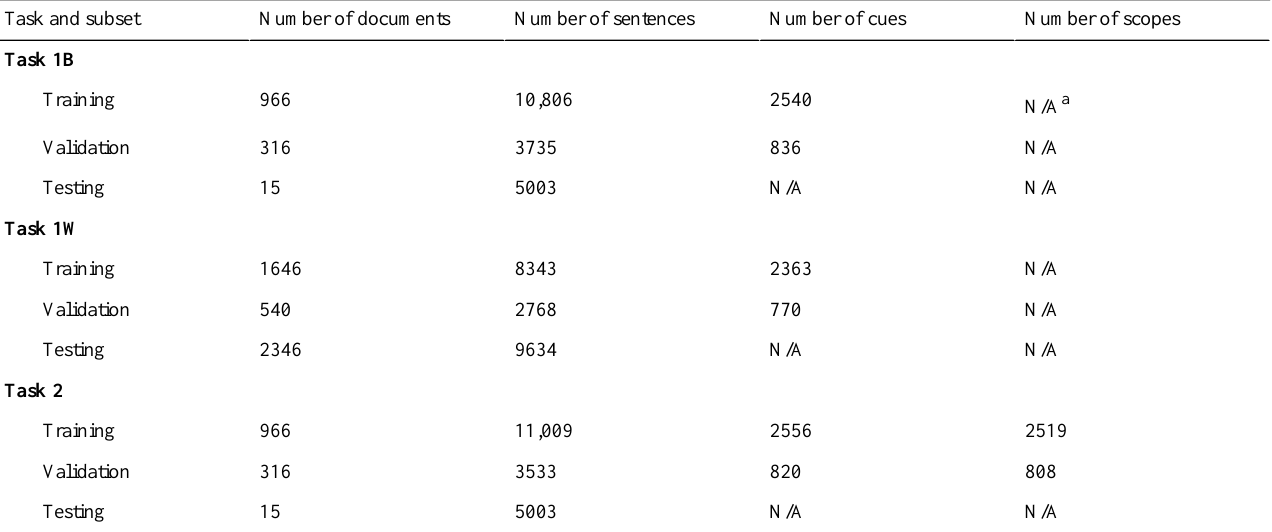
Table 7. BioScope subtask data sets.